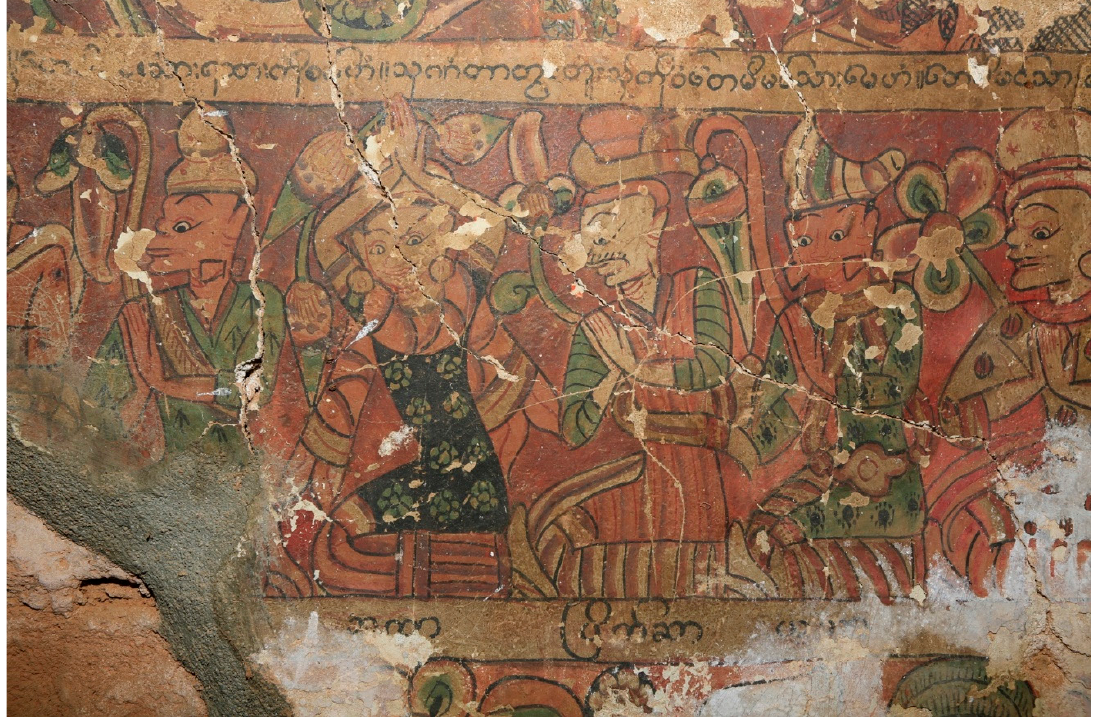
Figure 47. Anaint, 18th century. Five representatives of the 101 Tribes, including a woman.